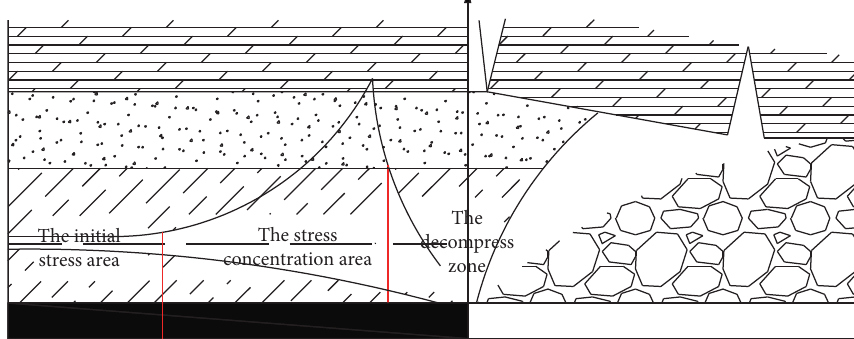
Figure 2: The stress distribution in front of mining working face [57].